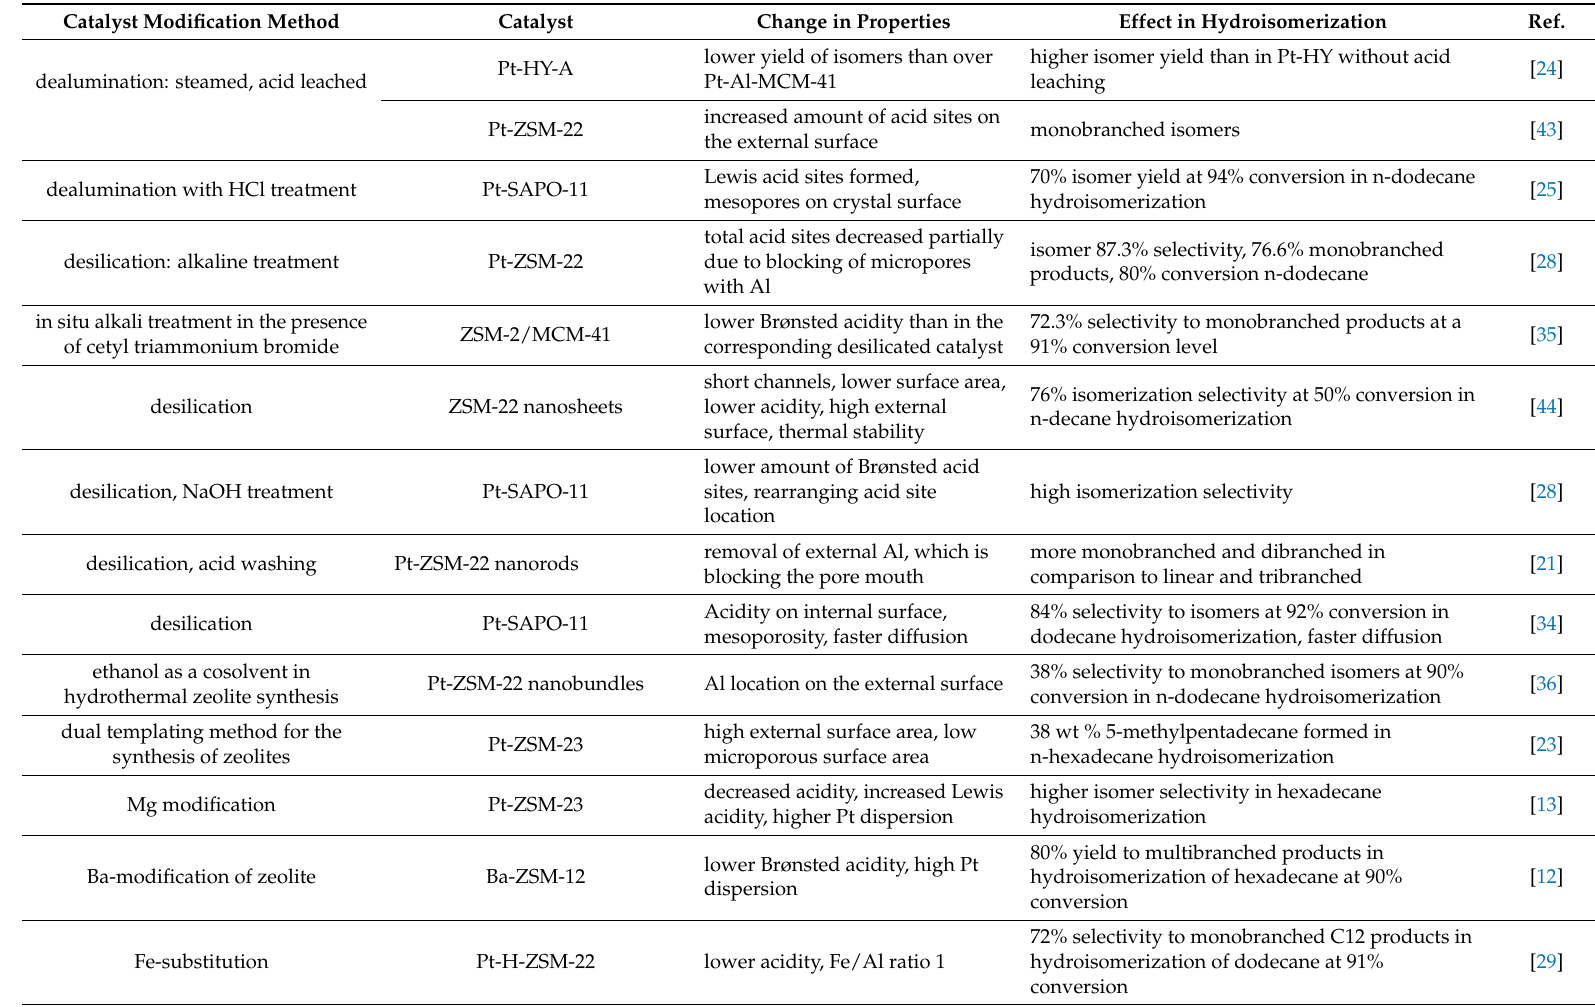
Table 3. Different method used for tailoring the catalyst acidity and